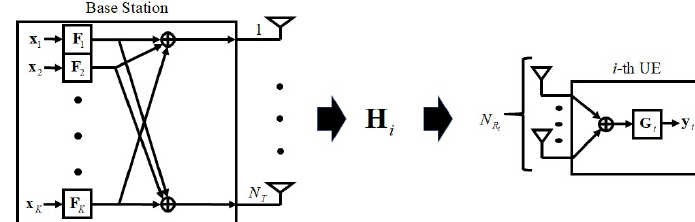
Figure 2. The equivalent single user (SU) model of the i -th user equipment